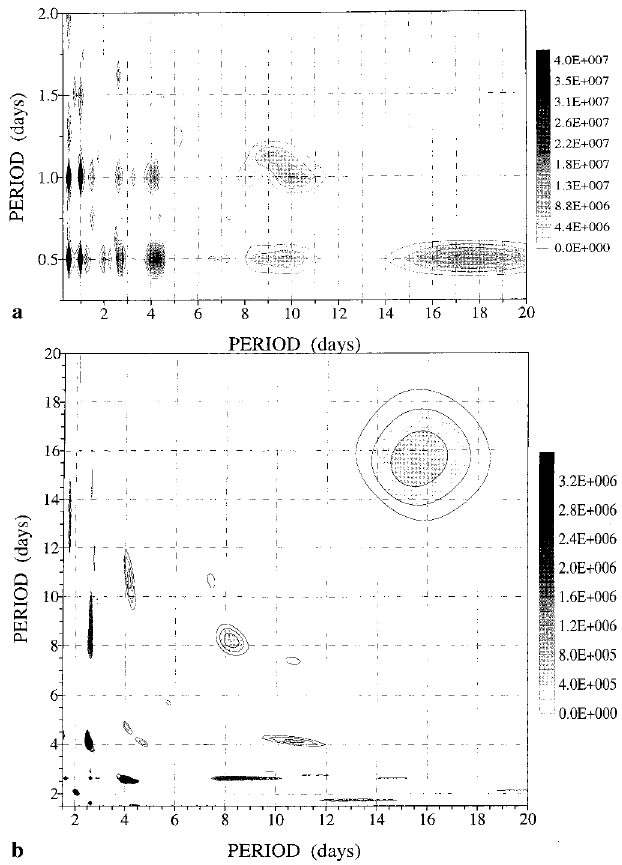
Fig. 4a, b. The contour plot of the magnitude squared bispectrum for the meridional wind during 01 January–23 October 1991 in the periodic interval: a 0.25–20 days, and b